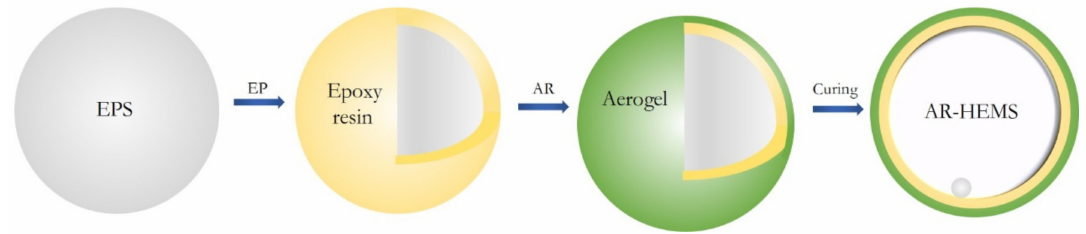
Figure 1. The schematic diagram of the preparation of the